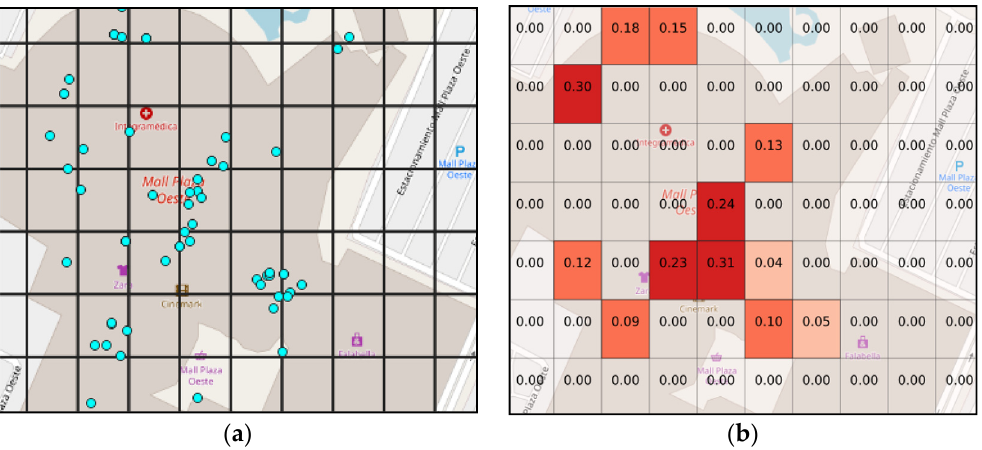
Figure 1. Example of geographical data ( a ) and belief computed for a certain region ( b ).